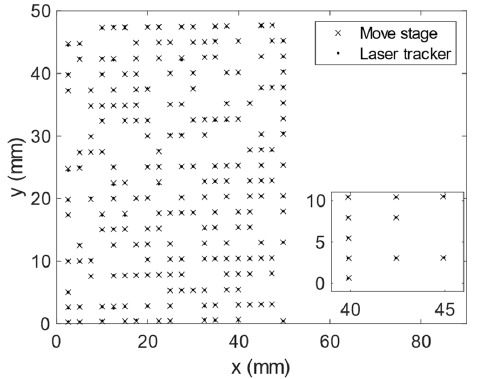
Figure 8. Calibration using IT2FLS for training data.